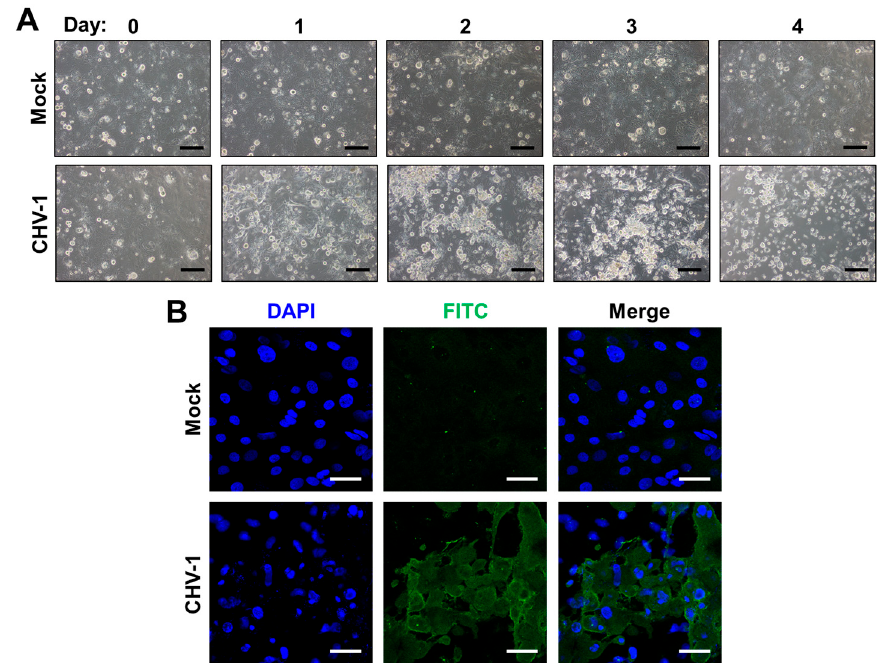
Figure 1. Canine corneal epithelial cells (CCECs) support the growth of canine herpesvirus type 1 CHV-1. CCECs were either mock-infected or infected at a multiplicity of infection (MOI) = 1 with the CHV-1 strain Duk. ( A ) Representative light micrographs of the course of the infection. Scale bar, 100 µm; ( B ) at 4 days post infection, CCECs were fixed in acetone and stained according to the manufacturer’s directions with a commercially available fluorescein isothiocynate (FITC)-conjugated anti-CHV-1 antibody (VMRD, Pullman, WA, USA; Cat#C5-F-CHV). Representative mock- and CHV-1-infected fields are shown. Scale bar, 100 µm. DAPI: 4’,6-diamidino-2-phenylindole.